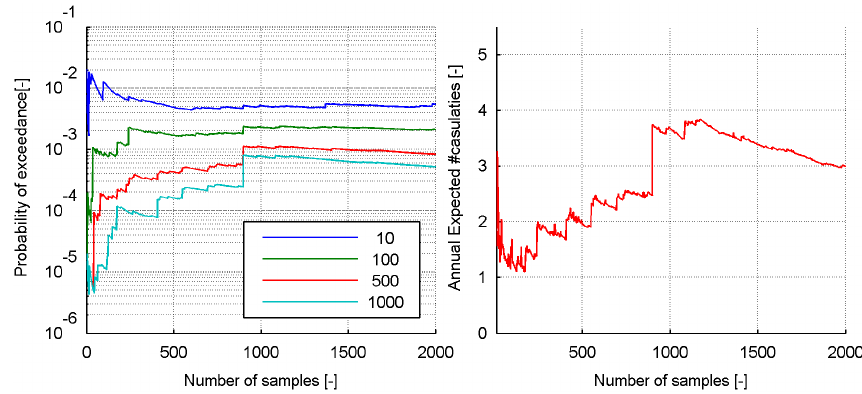
Figure 5. Convergence of the probability of exceedance of events with more than 10, 100, 5000 and 1000 fatalities (left) and the annual number of fatalities